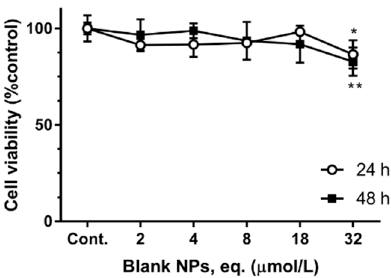
Figure 5. The effect of blank NPs on Y-79 cell viability. Y-79 cells were exposed to blank NPs, for 24 and 48 h, as denoted. Statistically significant differences, p < 0.05, are denoted with * or **, in relation to respective control at 24 or 48 h, respectively. The results are the mean ± S.D. of n = 4.